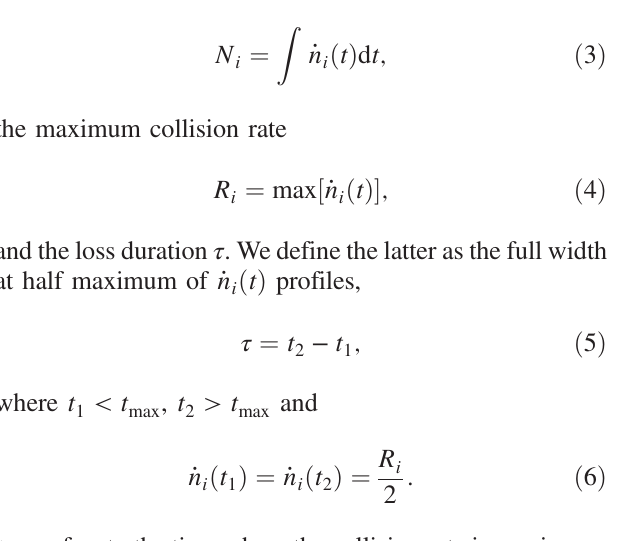
FIG. 6. Rate of inelastic nuclear collisions _ n i ð t Þ between 6.5 TeV protons and a dust particle entering the LHC beam. The two events were recorded in the LHC arcs in run II. In both cases, the losses lead to a magnet quench. The loss rate was reconstructed from BLM measurements using particle shower simulations. The time resolution of the measurements is 40 μ s. The labels in the figure indicate the integral number of collisions per event ( N i ), the maximum collision rate ( R i ) and the loss duration τ . The different variables are discussed in more detail in Sec. III